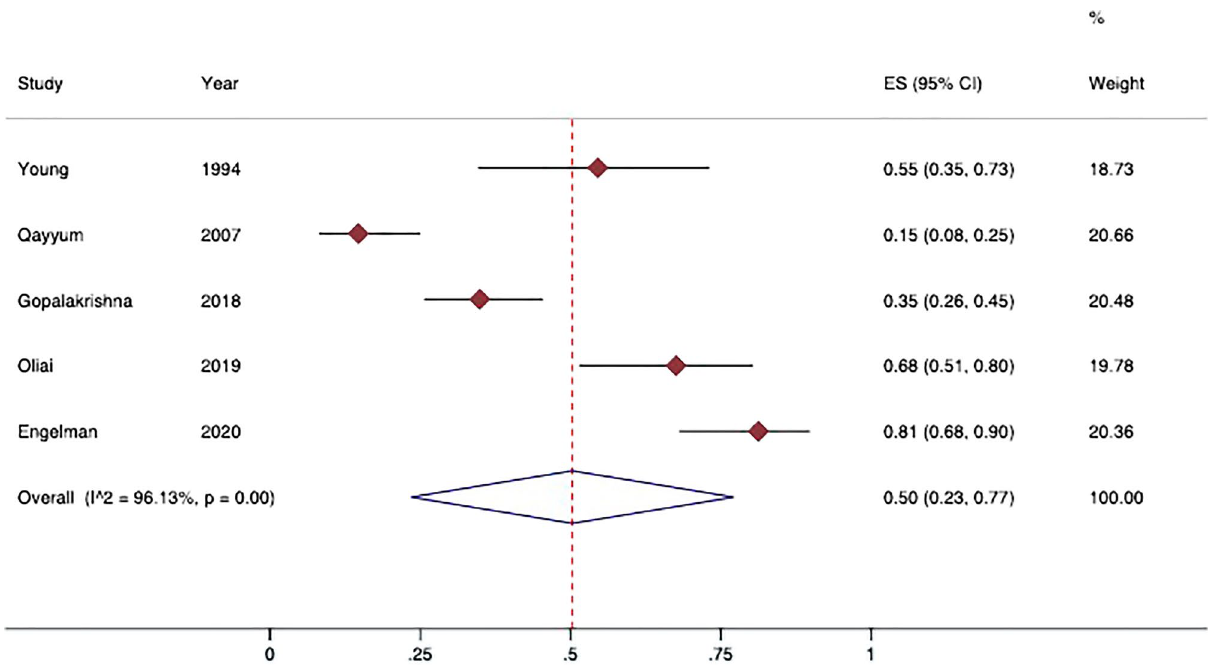
Figure 2. Prevalence of ascites in patients with pseudocirrhosis. Forest plot of overall pooled prevalence of ascites (random effect model); data from observational studies. 95%CI: 95% Confidence Intervals; ES: effect size; I 2 :